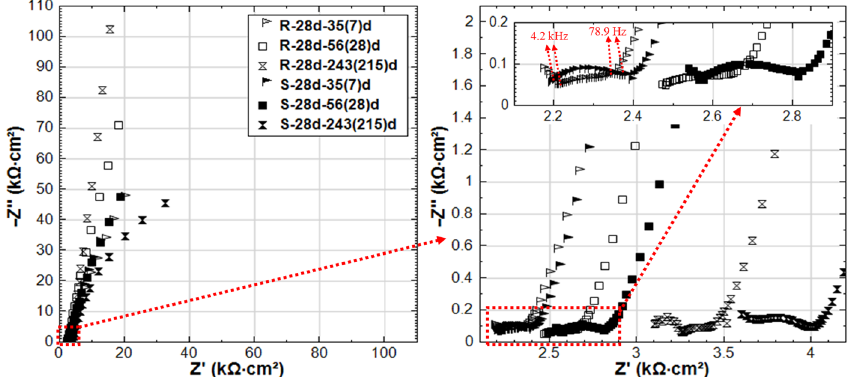
Figure 9. EIS responses overlay in Nyquist format of R-28d and S-28d (R-28d: Reference, S-28d: Stray Current, 28d-cured specimens treated in water).